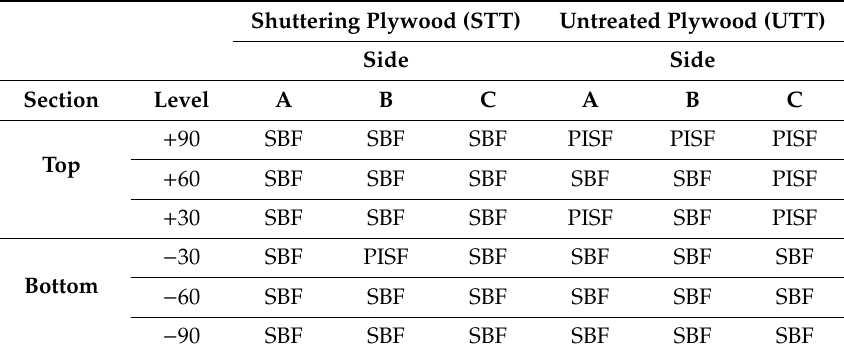
Figure 11. Binarized images of core surface showing fragments of UHPC and NSC ( a ) shuttering plywood; ( b ) untreated plywood. Table 5. Pull-o ff test failure modes of composite specimens using shuttering and untreated plywood for casting. Bond failure mode ID—SBF is substrate failure; OF is overlay failure; IF is interface failure; and PISF is partial interface–substrate